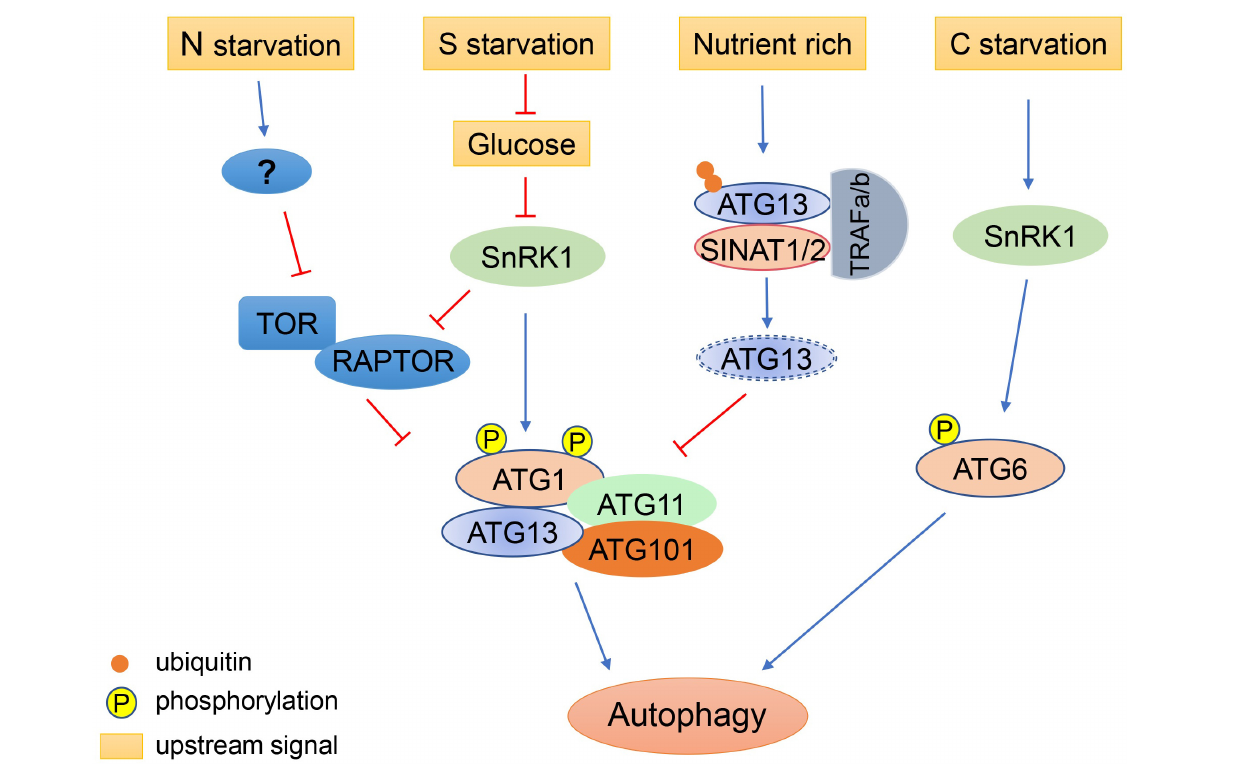
FIGURE 2 | Regulation of autophagy initiation under different nutritional conditions. Autophagy is induced by nitrogen (N) starvation in plants through inhibition of TOR. Sulfur (S) starvation regulates autophagy through the repression of glucose signaling, resulting in the activation of SnRK1, which inhibits TOR and activates the ATG1 autophagy initiation complex. Under nutrient-rich conditions, ATG13 is ubiquitinated by the SINATs-TRAF1s complex and degraded via the proteasome pathway, maintaining low levels of autophagy. Under prolonged carbon (C) starvation, ATG6 can be phosphorylated by SnRK1 to initiate autophagy via an ATG1-independent